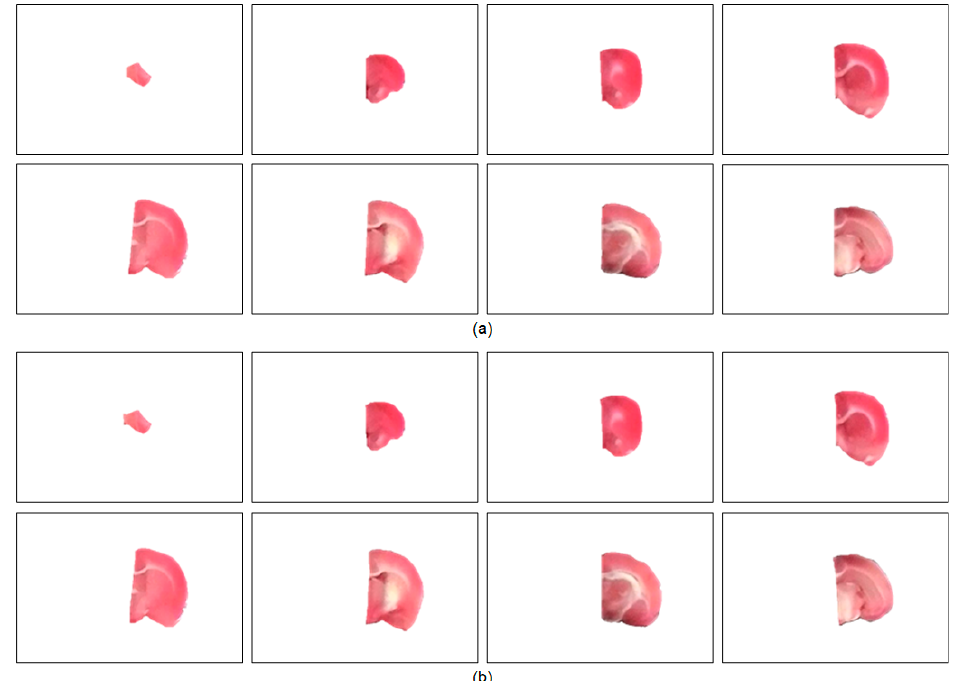
Figure 7. Visual evaluation of the left hemisphere segmentation results of Subject 16. ( a ) The proposed algorithm. ( b ) The gold standard. The κ D values were 93.06%, 98.29%, 97.92%, 98.22%, 98.51%, 97.53%, 99.02% and 96.52% from top left to bottom right, respectively.